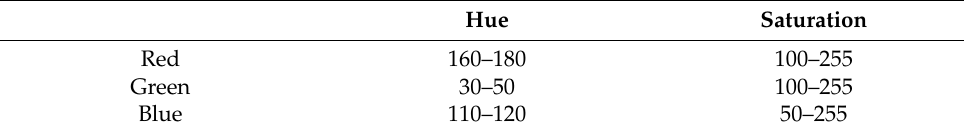
Table 3. Color threshold for point cloud segmentation by colorimetry.